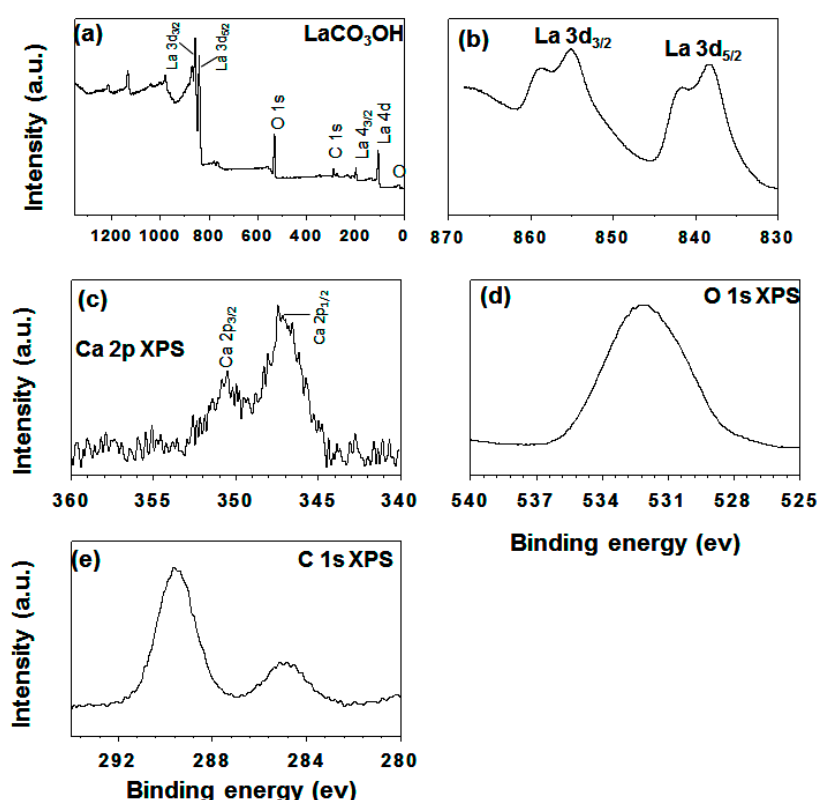
Figure 6. Typical as-synthesized LC-3 XPS spectra: ( a ) survey spectrum, ( b ) region La 3d; ( c ) region Ca 2p, ( d ) region O 1s, and ( e ) region C 1.